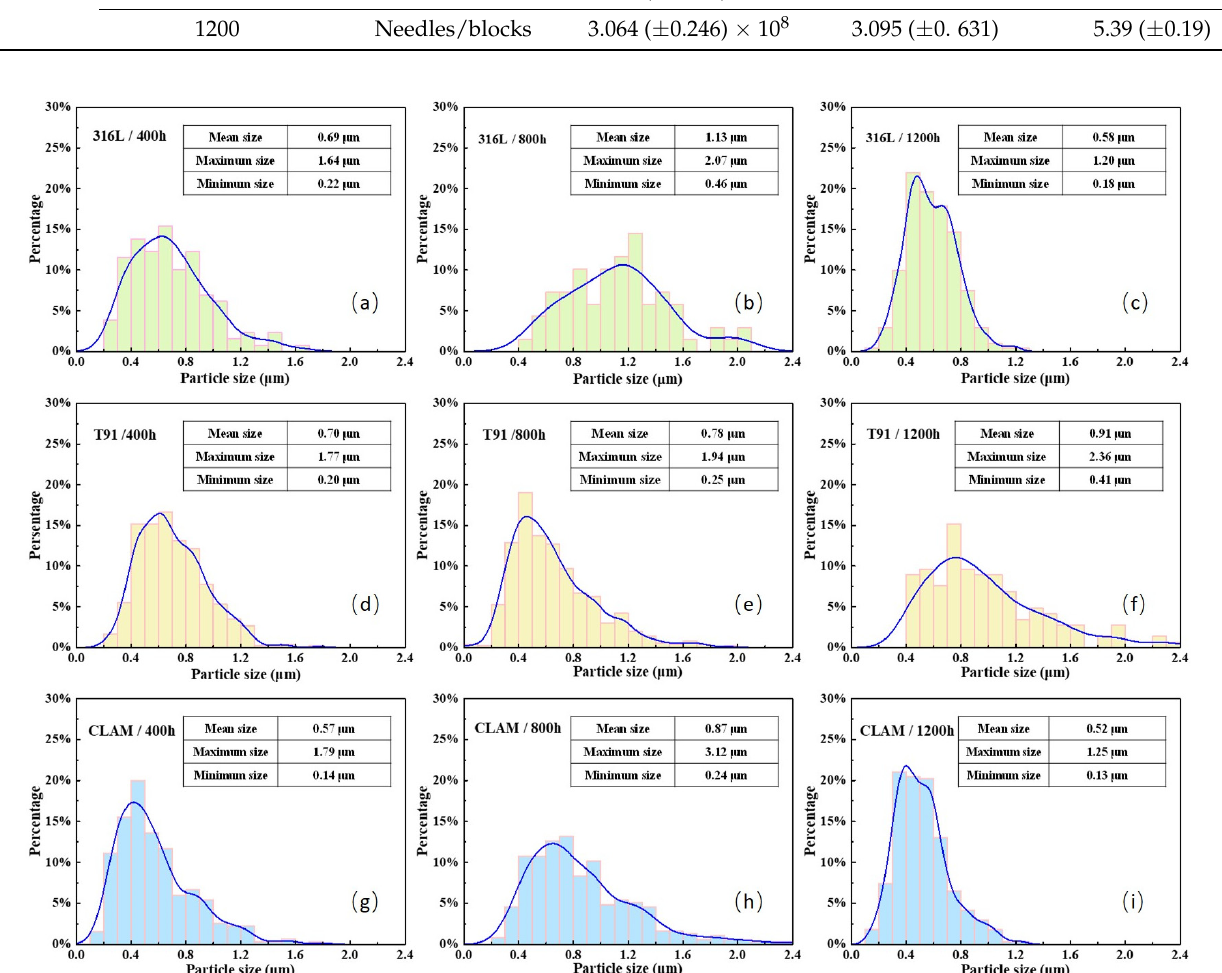
Figure 9. Statistical size distribution of corrosion products on the corroded sample surface: ( a ) 316L-400h, ( b ) 316L-800h, ( c ) 316L-1200h, ( d ) T91-400h, ( e ) T91-800h, ( f ) T91-1200h, ( g ) CLAM-400h, ( h ) CLAM-800h, ( i ) CLAM-1200h. Table 2. Statistical density, structure, roughness, and oxide layer thickness of the corroded sample surface.